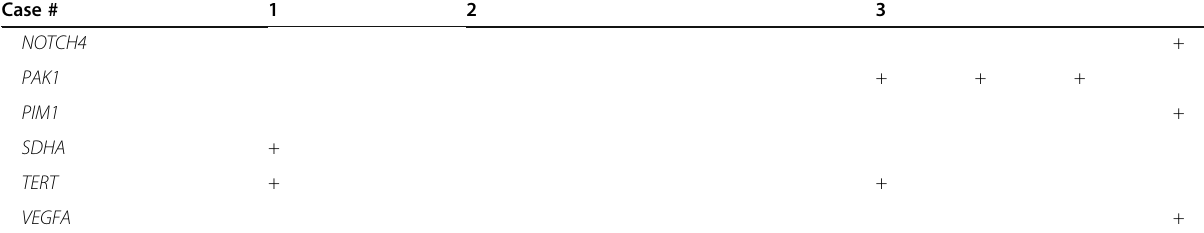
Table 1 Genomic alterations detected by NGS profiling of pulmonary resections from three cases